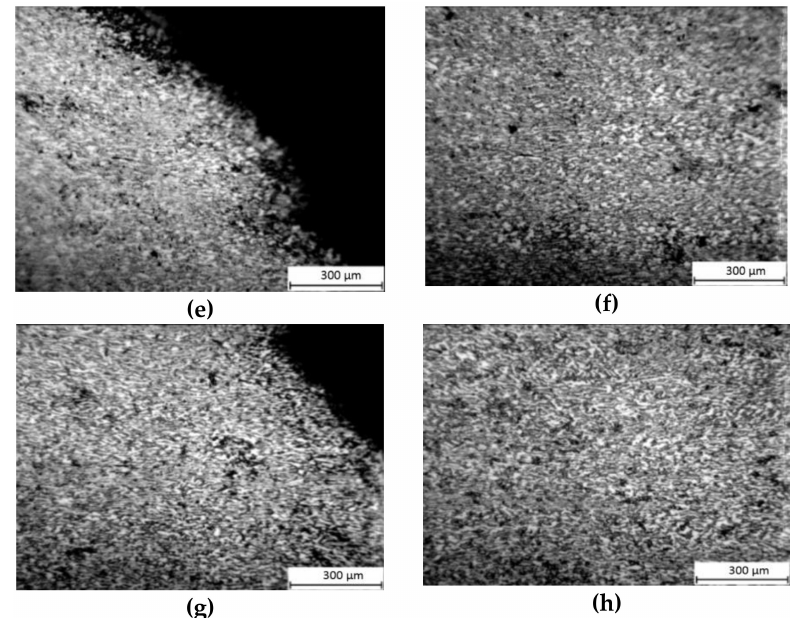
Figure 2. Microstructure of specimens from alloy VT23 in the initial state ( a , b ), under static stretching ( c , d ), DNP1 ( e , f ), and (DNP2) ( g , h ).